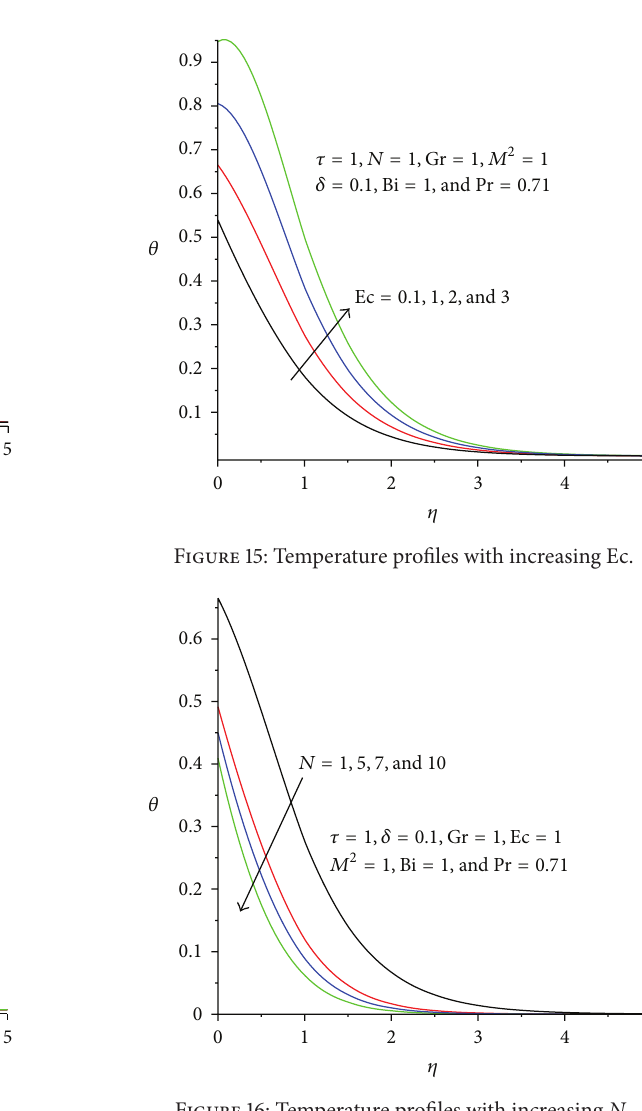
Figure 16: Temperature profiles with increasing 𝑁